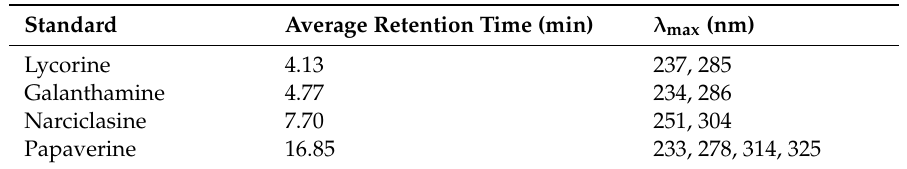
Table A3. Details pertaining to the HPLC analysis of alkaloid standards. The average retention time and absorption maxima of each alkaloid standard obtained by HPLC-PDA analysis are summarized in the